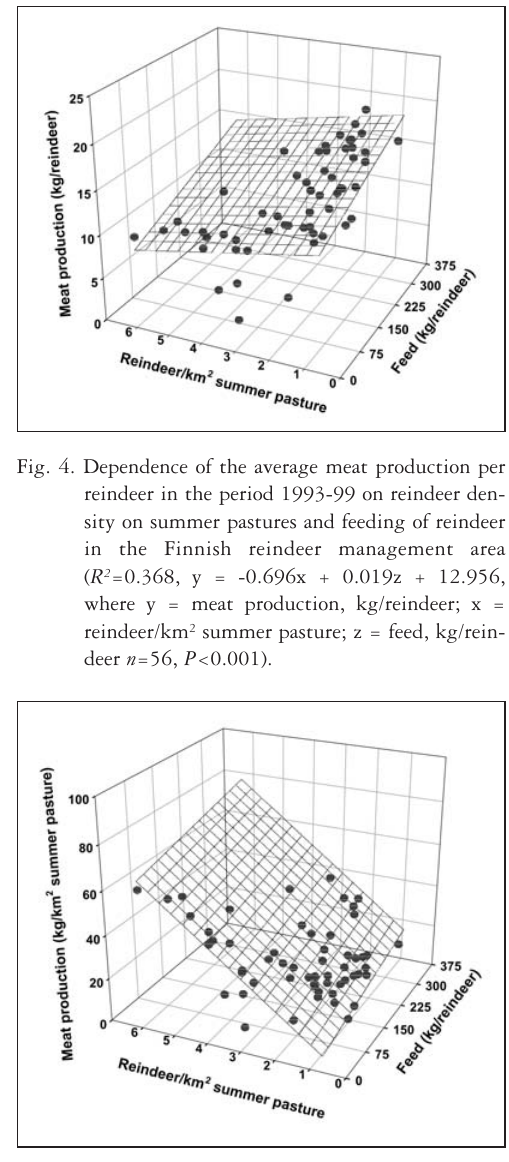
Fig. 5. Dependence of the average meat production per km 2 summer pasture in the period 1993-99 on reindeer on reindeer density on summer pastures and feeding of reindeer in the Finnish reindeer management area ( R 2 =0.743, y = 11.332x + 0.045z - 2.198 where y = meat production, kg/km 2 summer pasture; x = reindeer density, reindeer/km 2 summer pasture; z = feed, kg/rein- deer; n =56, P od when analyzing the entire management area. A decrease in available winter pastures and amount of natural winter fodder has accelerated since the